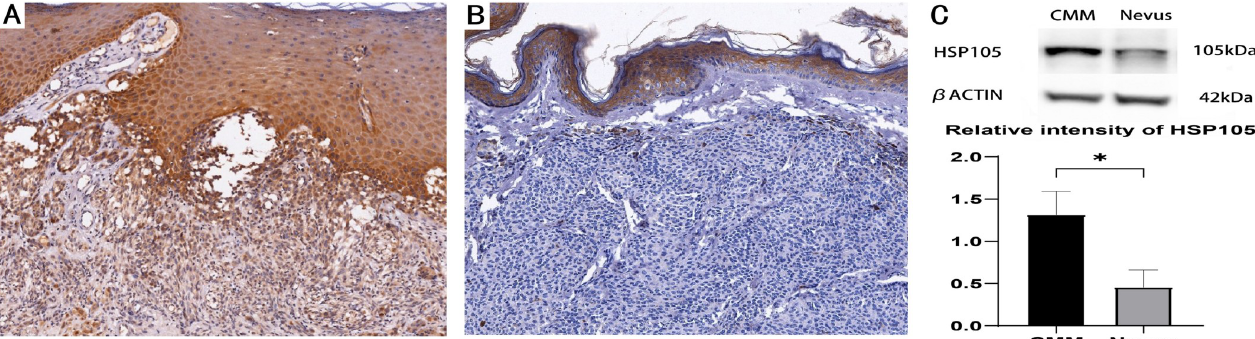
Fig 1. HSP105 expression in CMM and nevus. (A) HSP105 expression in CMM with intense staining (IHC, × 100). (B) HSP105 expression in Nevus with weaker staining (IHC, × 100). (C) The Western blot analysis of HSP 105 expression in CMM and Nevus. Comparison was showed in the column graph. Values represent the mean ± SD. � , P <